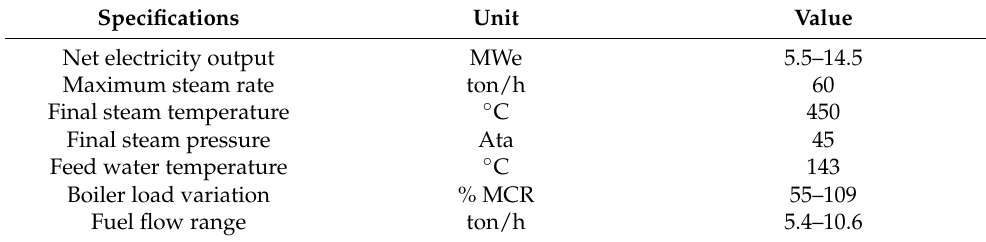
Figure 2. Process diagram of 60 ton/h CFBC boiler. (1) Fuel surge bin, (2) Drum, (3) Combustor, (4) Cyclone, (5) S/H(superheater) 2, (6) de-superheater, (7) S/H(superheater) 1, (8) Economizer, (9) Air pre-heater, (10) P.A. Fan, (11) SDR (Semi-Dry Reactor; HCl and SOx absorption), (12) Bag filter 1, (13) Bag filter 2, (14) I.D. Fan. Table 1. Design specifications.